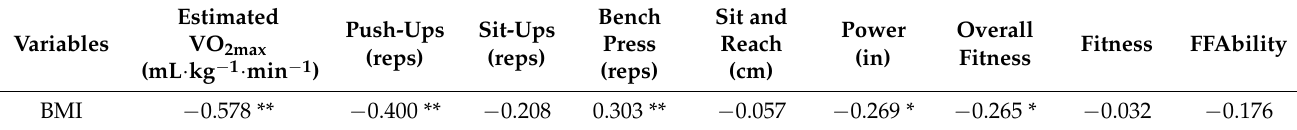
Table 8. Relationship between Fitness and BMI at Week